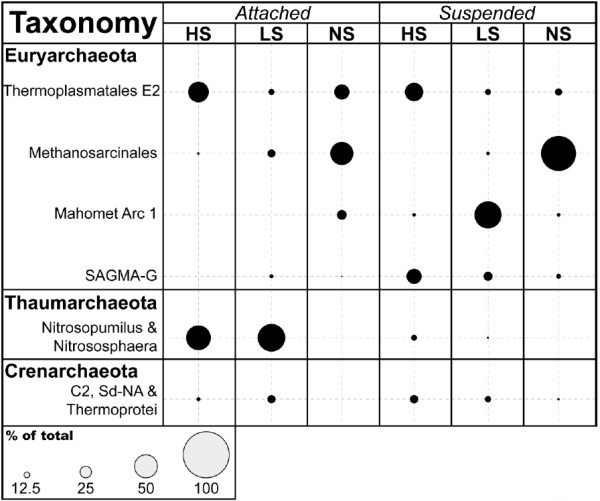
The taxonomy and relative distribution of archaeal populations attached to the sediment of in situ samplers. Sequences were classified to the genus level in Mothur [33] with the “Hugenholtz” taxonomic nomenclature in Greengenes [34]. The area of each circle is proportional to the percentage of sequences represented by that class within those wells, which are grouped together according to the concentration of sulfate in groundwater.